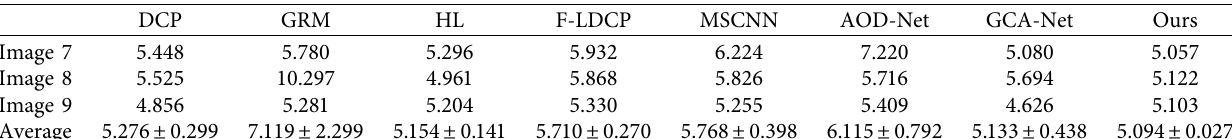
Table 3: NIQE comparison of various image enhancement methods on all test images shown in Figure 6. The best results are highlighted in bold.